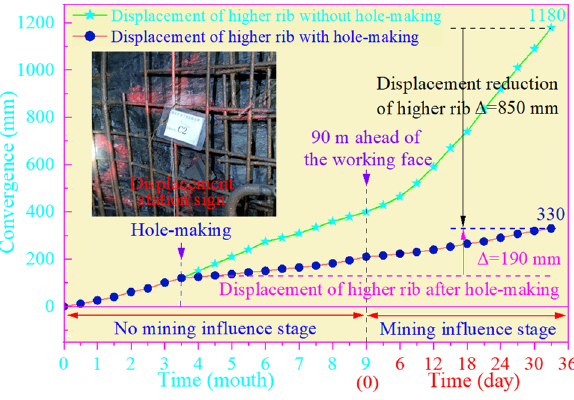
Figure 21. Deformation curve of coal roadway surrounding rock.